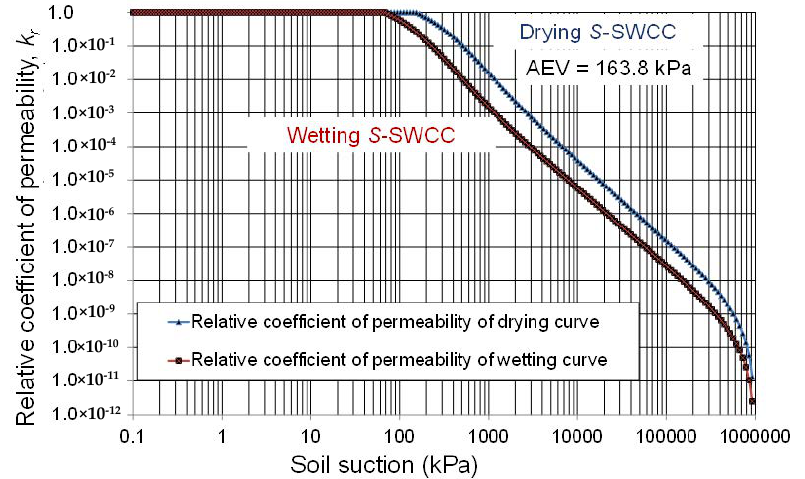
Figure 26. Relative coefficient of permeability curves corresponding to the drying and wetting S - SWCCs.